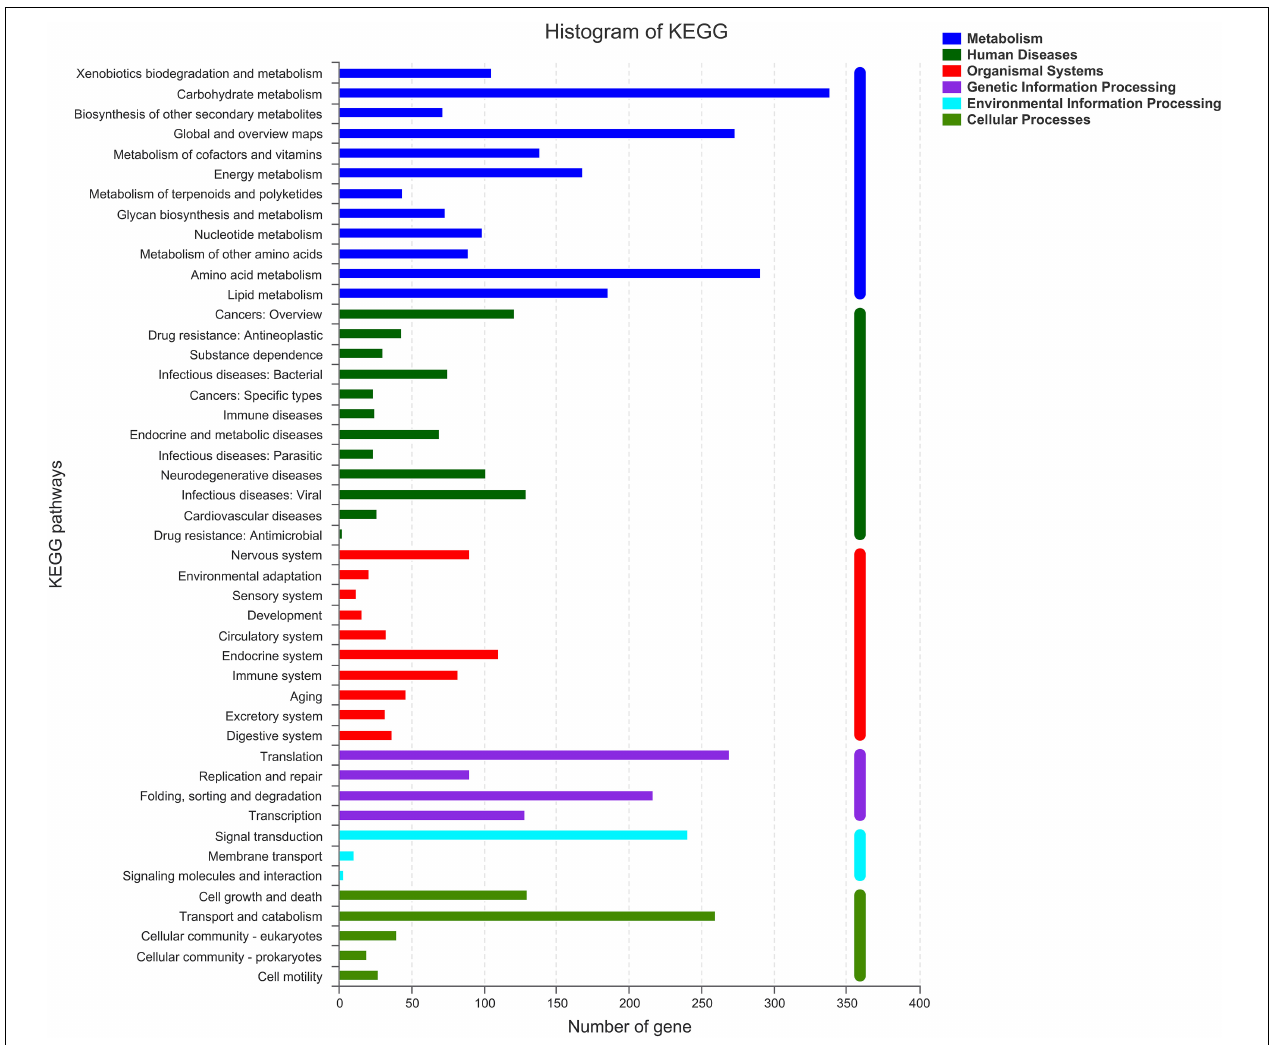
FIGURE 5 | Clusters of KEGG